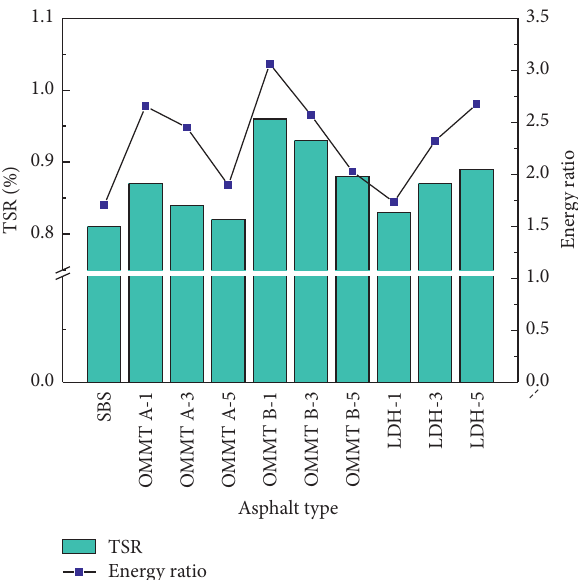
Figure 11: Tensile strength ratios (TSRs) obtained from freeze- thaw splitting tests and ERs of the systems of binders and